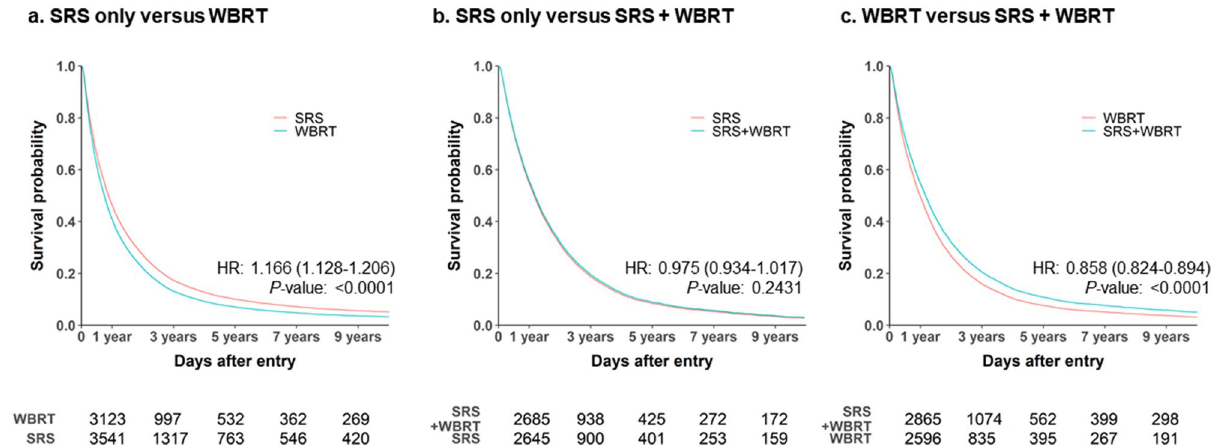
Figure 4. Cox regression survival analyses for SRS only vs. WBRT ( a ), SRS only vs. SRS + WBRT ( b ), and WBRT vs. SRS + WBRT ( c ). Cox proportional hazards model adjusted for age, sex, CCI, chemotherapy use, surgery use, diagnostic year, and primary tumor location. WBRT whole-brain radiotherapy, SRS stereotactic radiosurgery, HR hazard ratio. Created using SAS software (version 9.4; SAS Institute Inc., Cray, NC,